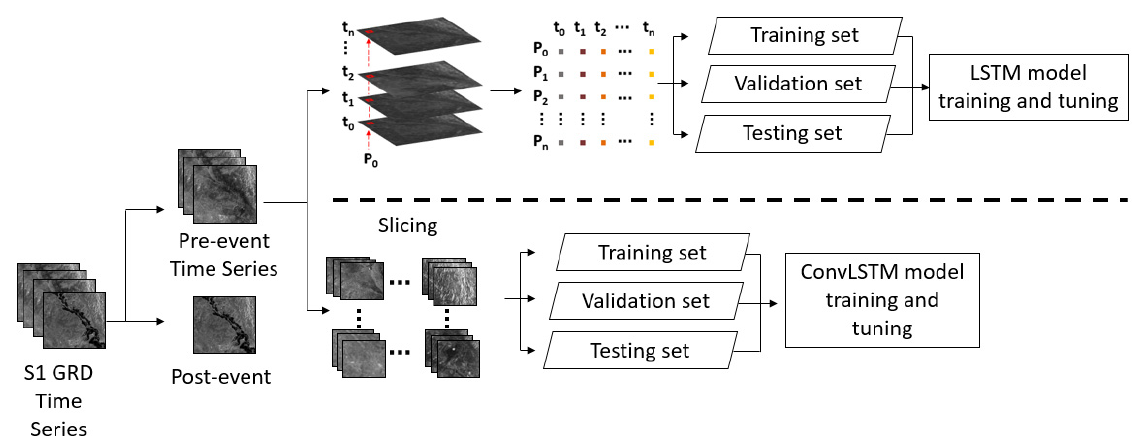
Figure 1. Processing workflow for the training of RNN LSTM and ConvLSTM models.